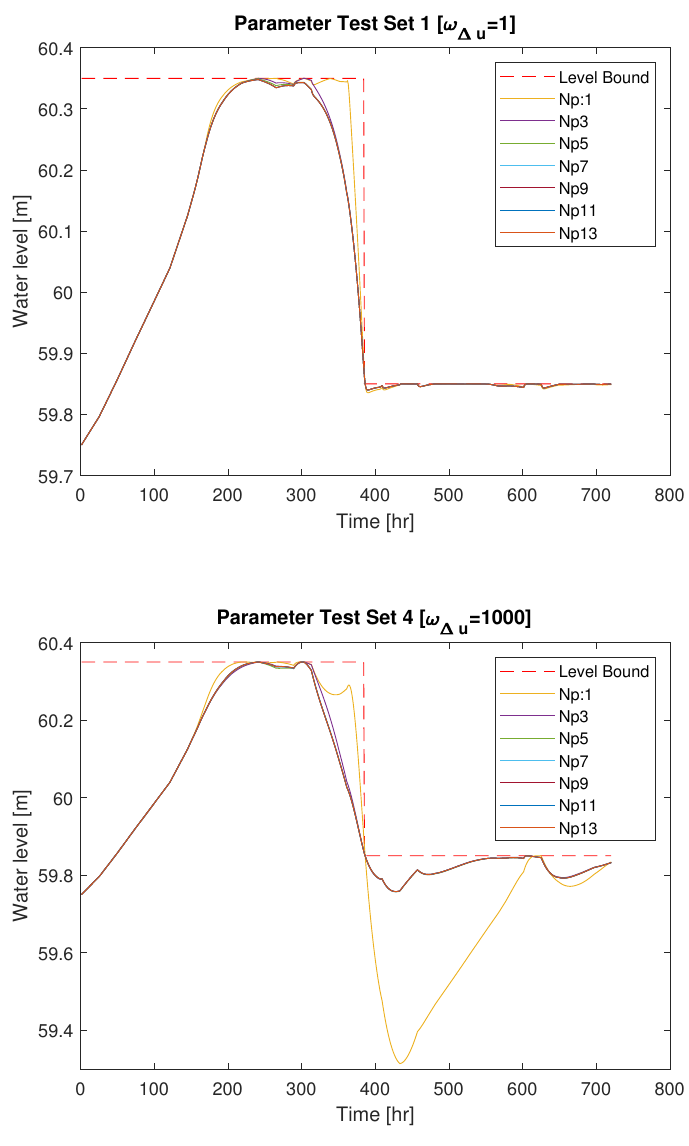
Figure 6. Change of the water level at Merkebekk during the simulations with parameter test set 1 and test set